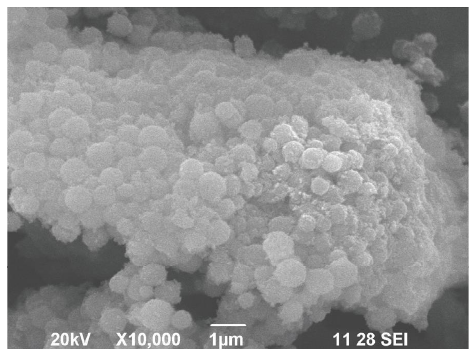
Figure 4: SEM image of silver nanoparticles.